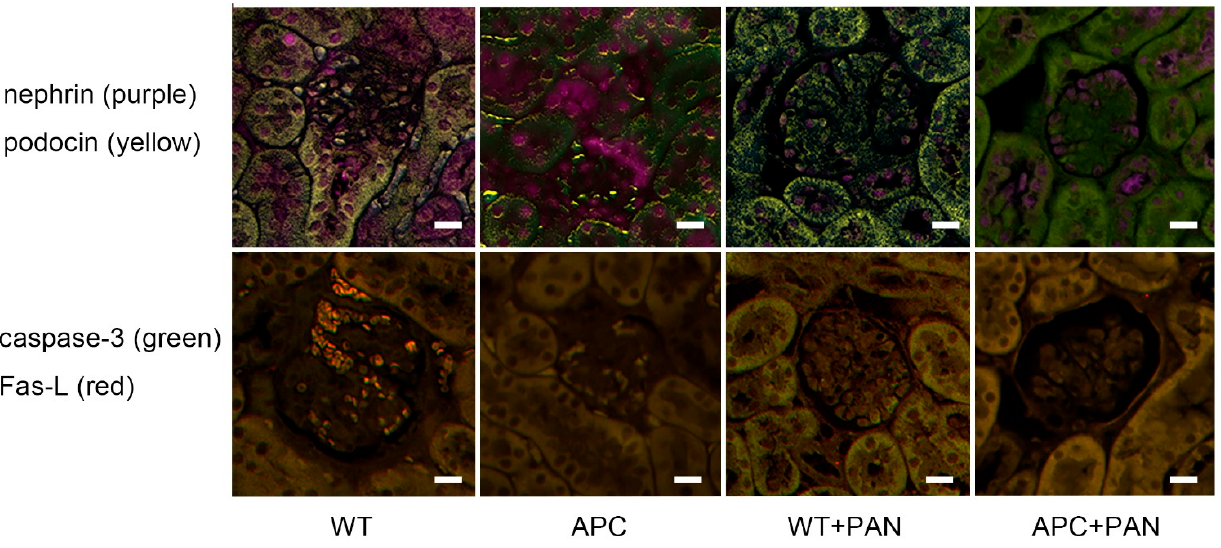
Figure 9. Immunofluorescence for nephrin (purple) and podocin (yellow) in the upper panels, caspase-3 (green) and Fas-Ligand (red) in the lower panels. WT indicates wild-type mice (WT), APC, APC1638T mice, WT+PAN, wild-type mice with PAN-induced nephrotic syndrome, and APC+PAN, APC1638T mice with PAN-induced nephrotic syndrome. The bar indicates 10 μ m.